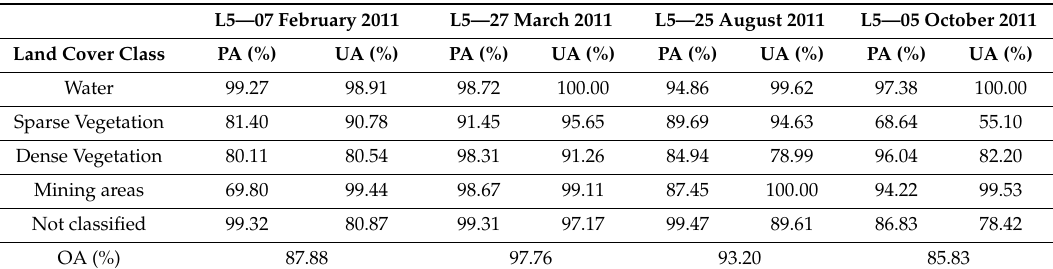
Table 14. OA, PA, and UA obtained computing STRed on the images acquired by Landsat 5 mission. UA, user’s accuracy; PA, producer’s accuracy; OA, overall accuracy.